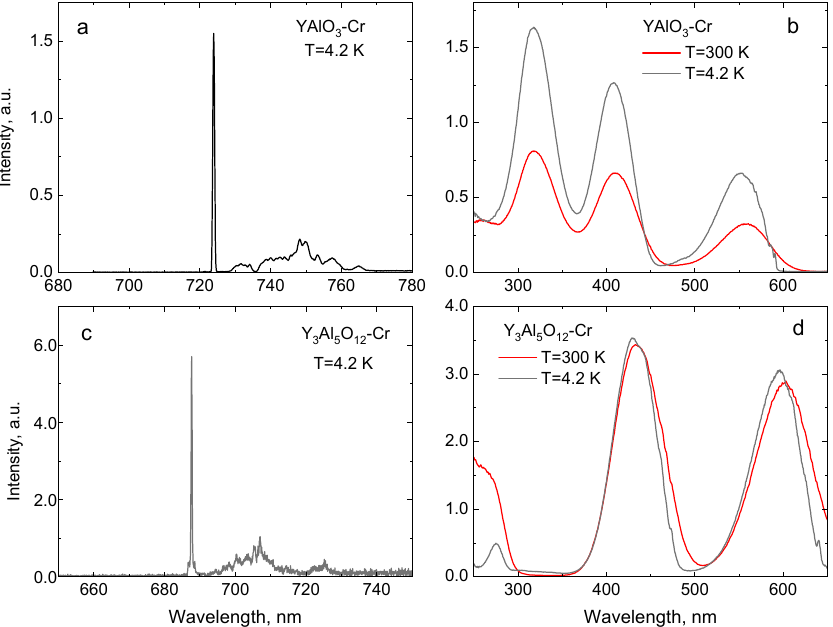
Figure 2. Luminescence ( a , c ) and luminescence excitation spectra ( b , d ) of YAlO 3 -Cr and Y 3 Al 5 O 12 -Cr.